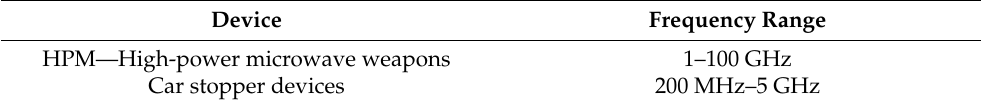
Table 5. EM directed-energy weapons and relative frequency